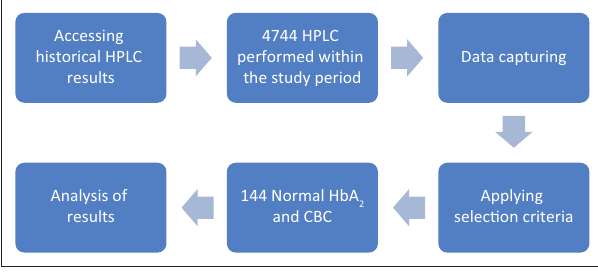
FIGURE 1: Flow diagram of the study design, Pretoria, South Africa, 01 October 2012 – 31 December